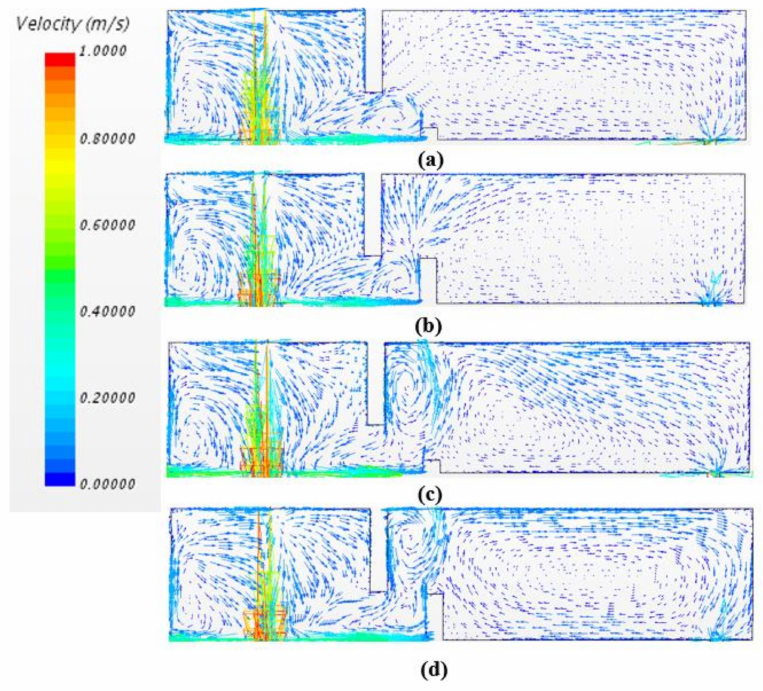
Figure 5. Velocity vectors at center longitudinal plane: ( a ) Case 1-W + LD, ( b ) Case 2-W + HD, ( c ) Case 3-W + LD + G, ( d ) Case 4-W + HD +